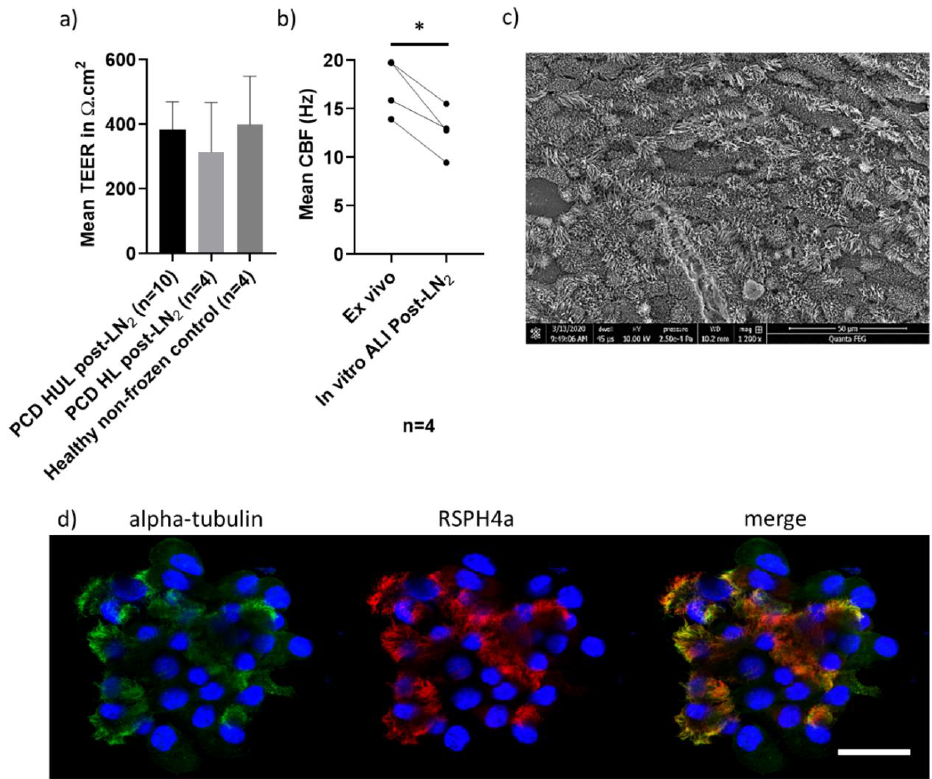
Figure 4. Characteristics of in vitro ALI cultures (ciliated and differentiated at passage 2) derived from frozen liquid nitrogen storage. ( a ) There was no difference in the mean (±SD) trans-epithelial electrical resistance (TEER) (Ω.cm 2 ) of n = 10 “PCD highly-unlikely” and n = 4 “PCD highly-likely” ALI cultures recovered from liquid nitrogen cryostorage (post-LN 2 ) (t test), or compared to n = 4 healthy donor sample (non-frozen) controls (Mann–Whitney test) measured in triplicate per Transwell ® insert at 4 weeks ALI culture, when cells were widely ciliated. ( b ) The mean CBF (Hz) of n = 4 matched PCD clinic samples differed before (ex vivo) and after liquid nitrogen storage (in vitro ALI culture) * p = 0.01 (paired t test). ( c ) A representative SEM image from a “PCD highly-unlikely” ALI culture showing typical ciliation at week 4 post-LN 2 . ( d ) Representative PCD diagnostic immunofluorescence [15] images from an SP8 laser scanning confocal microscope, showing a PCD clinic ALI culture after cryostorage with 4% paraformaldehyde fixation and immunofluorescence labelling with anti-alpha- tubulin (cilia marker-Alexa488 secondary antibody, green), anti-RSPH4a (radial spoke head protein- Alexa549 secondary antibody, red) and DAPI (nuclei DNA stain, blue). Scale 20 µm. The physical barrier properties, measured by TEER at 4 weeks post-ALI, of n = 10 thawed “PCD highly-unlikely” 383 Ω.cm 2 (SD ± 86.5) and n = 4 defrosted “PCD highly-likely” 314 Ω.cm 2 (SD ± 153.9) samples were not significantly different to each other (t test) or to n = 4 representative fresh (non- frozen) healthy donor in vitro ALI cultures 299 Ω.cm 2 (SD ± 97.6) (Mann–Whitney test) (Figure 4). HSVA demonstrated that n = 4 representative “PCD highly-unlikely” samples with mean nasal brushing CBF of 17.3 Hz, SD ± 2.9 (ex vivo) resolved a normal CBP with mucociliary clearance with a significantly reduced mean CBF of 12.7 Hz, SD ± 2.5 in matched samples that were ALI-cultured (4 weeks) after liquid nitrogen storage (paired t test, p = 0.01); while three of these cultures retained a normal CBP, one culture’s CBF fell just below the UHS normal range (11–20 Hz) [27] (Figure 4). Six